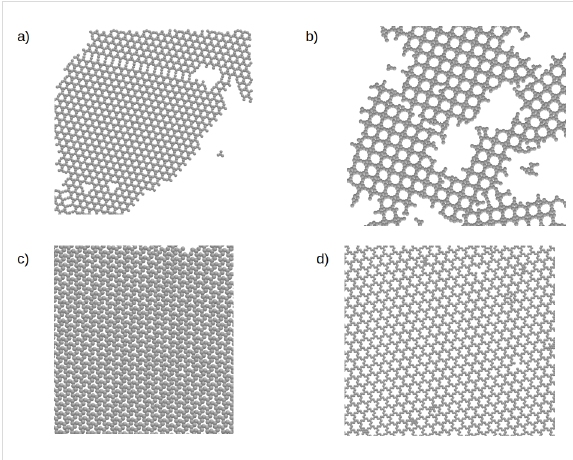
Figure 2: Part of the configurations for a) NT111 at T * = 0.58, b) NL111 at T * = 0.54, and c) WT111 at T * = 0.58, all with ρ * = 0.2. d) Corresponding Monte Carlo simulation on a triangular lattice for WT111 at T * l − MC =